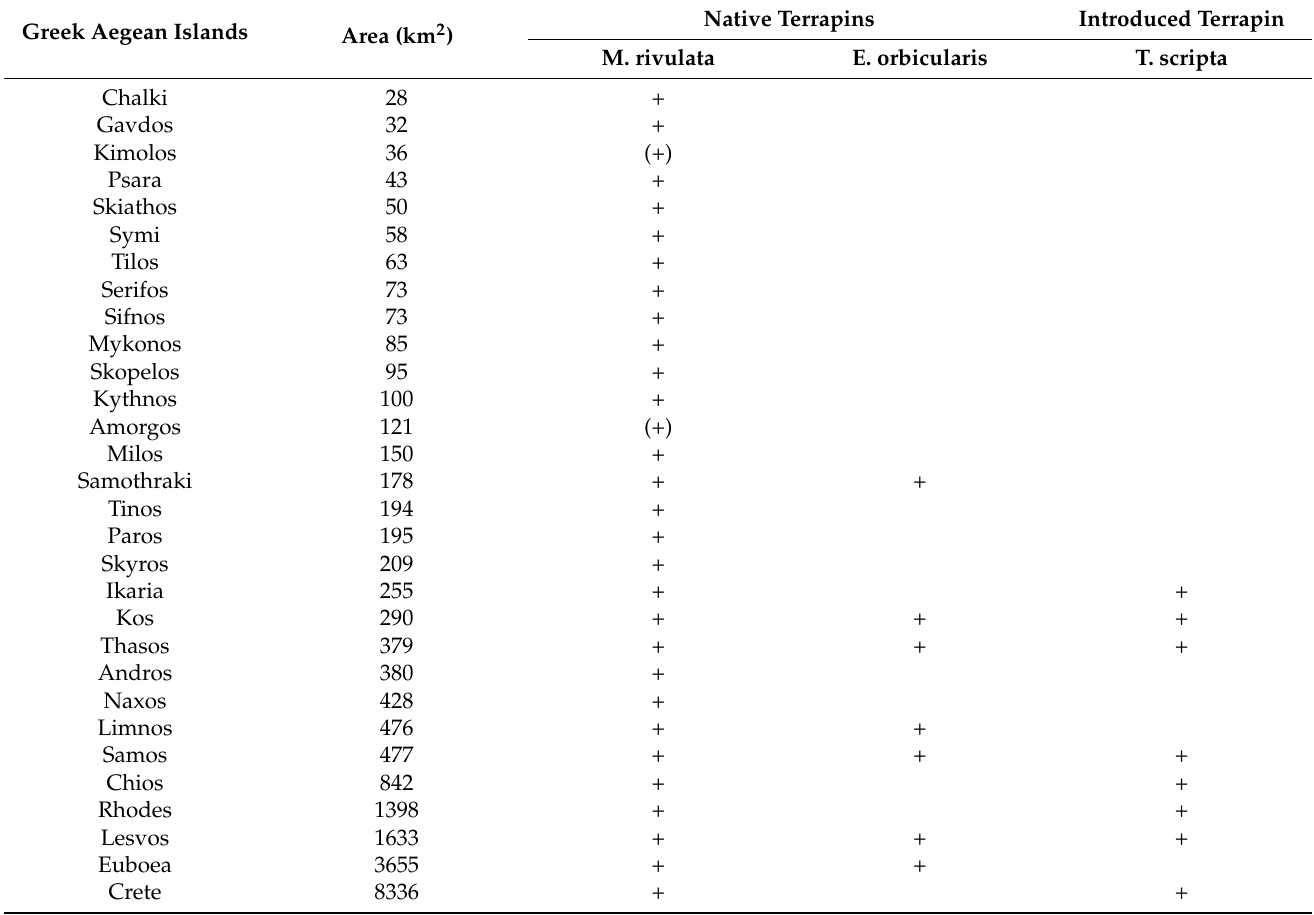
Table 1. Presence + and possible presence (+) of the freshwater turtles in the Greek Aegean islands. Native Terrapins Introduced Terrapin Greek Aegean Islands Area (km 2 ) M. rivulata E. orbicularis T.